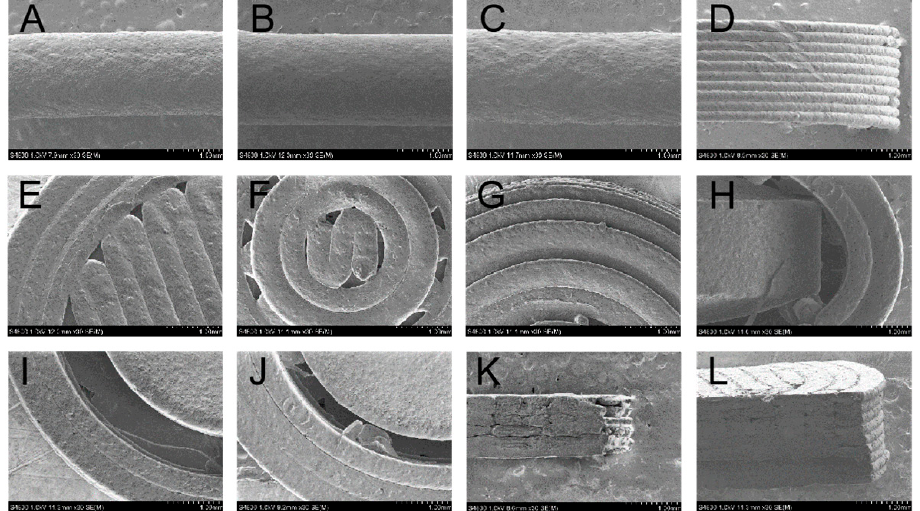
Figure 5. SEM images of the filaments and tablets: ( A ) surface of F90, ( B ) surface of F95, ( C ) surface of F98, ( D ) partial lateral surface of FH-95-266, ( E ) top of FH-95-266, ( F ) and ( G ) top of CH-95-266, ( H ) cross section of FU-95-266, ( I ) cross section of FH-95-266, ( J ) cross section of FH-95-366, ( K ) top of vertical section of FH-95-266, ( L ) bottom of vertical section of FH-95-399. The scale bar represents 1.00 mm.